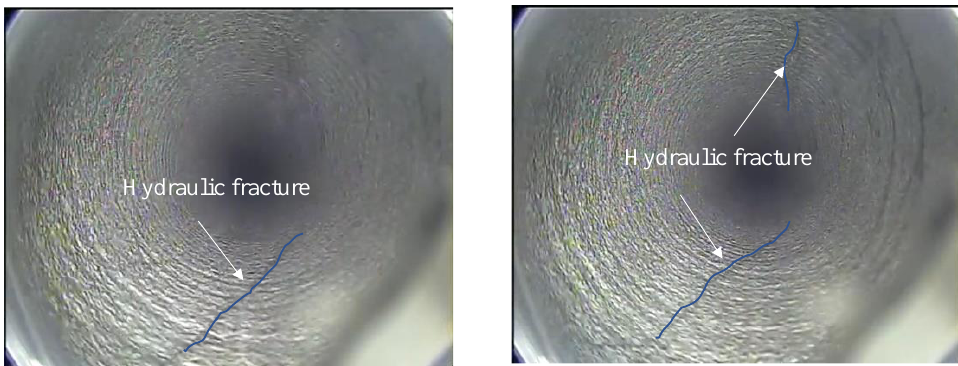
Figure 17. Fracture distribution characteristics of hydraulic fracturing boreholes.